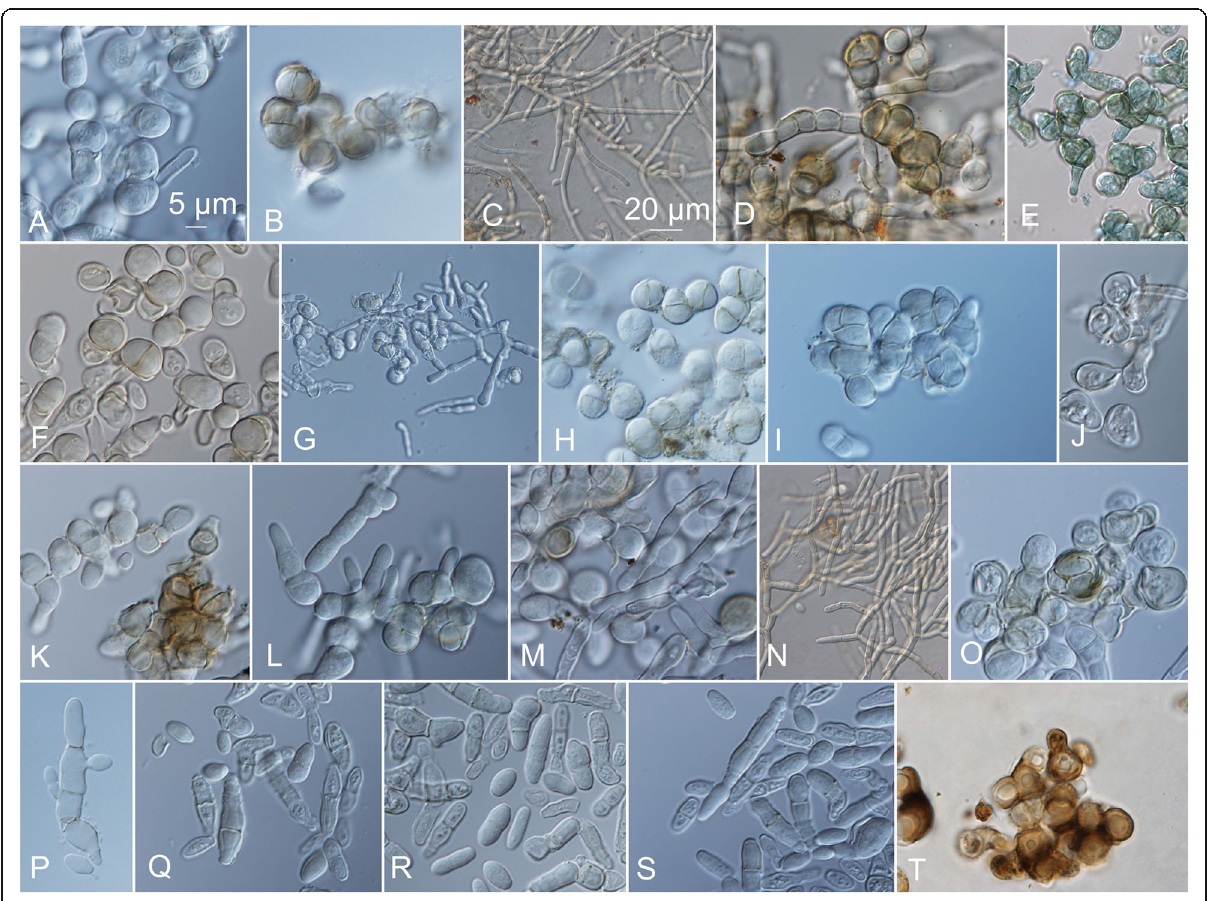
Fig. 15 Growth of Hortaea werneckii strains after 21 days at 37 °C on solid malt extract agar (MEA) medium supplemented with 10% NaCl (if not indicated otherwise). a , b EXF-120. c , d EXF-151 T . e EXF-151 T in liquid YNB. f EXF-157. g EXF-225. h EXF-269. i EXF-537. j EXF-561. k EXF-631. l EXF-2690. m EXF-3506. n EXF-6651. o , p EXF-7620. q EXF-10508 (on MEA). r EXF-105012 (on MEA). s EXF-10513. t EXF-11537 (on MEA). Bar =5 μ m ( a , b , d - f , h - m , o - t ), 20 μ m ( c , g , n